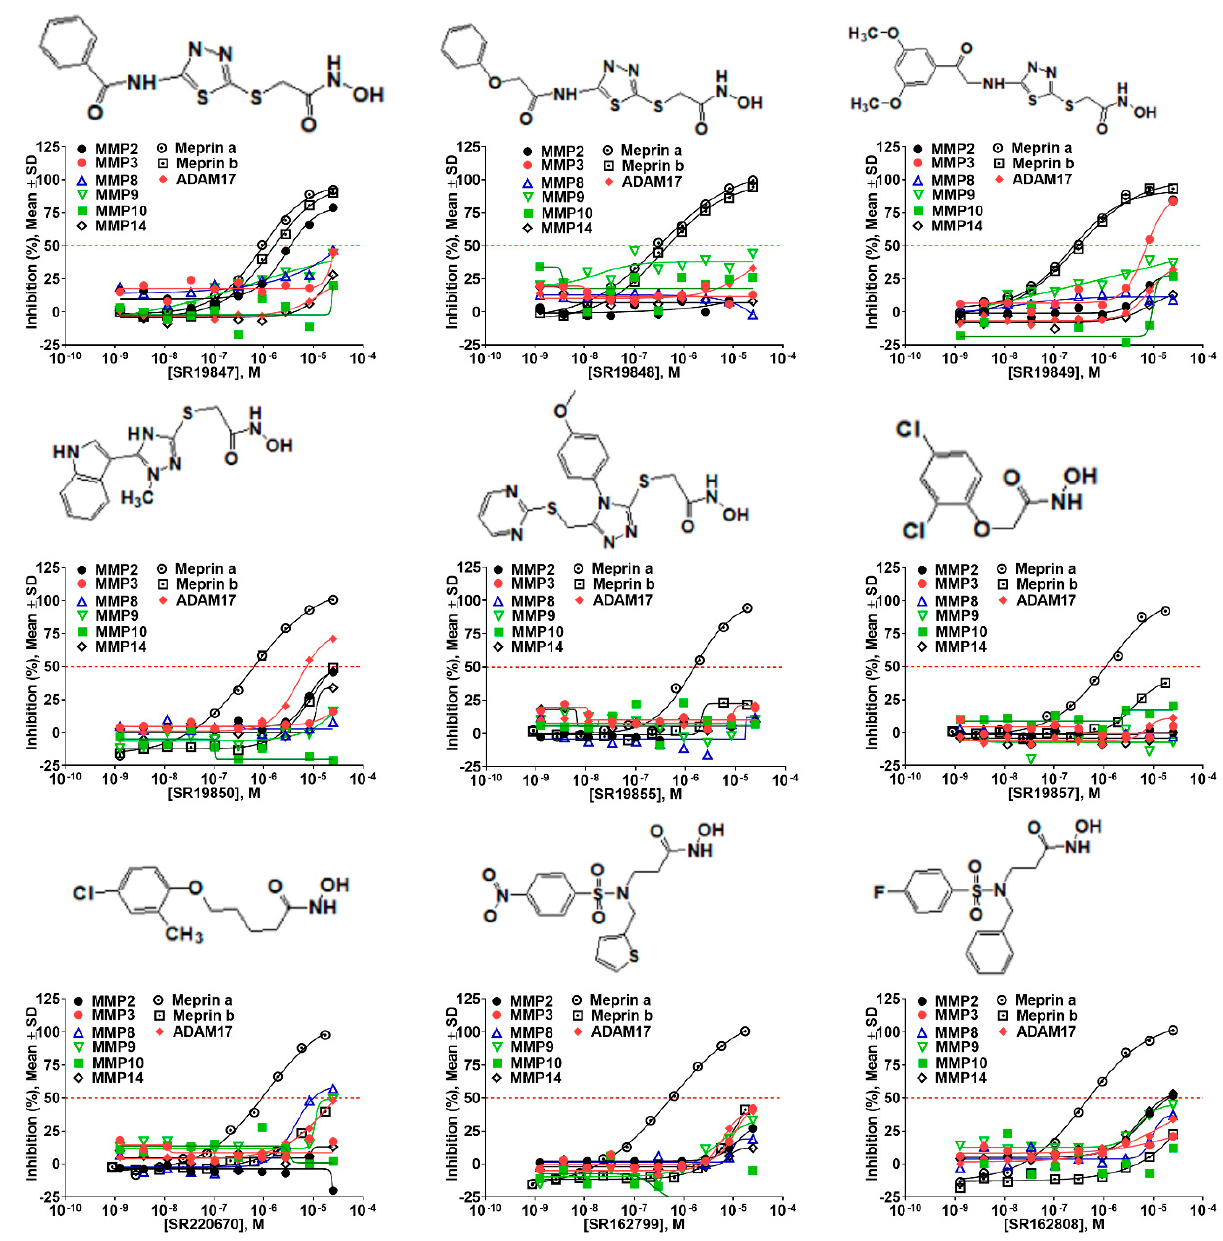
Figure 6. Results of concentration response studies of top potent and selective meprin α inhibitors. The top meprin β inhibitors belonged to two structural families (Figure 7 and Table 3), isobutyryl-tetrahydronaphthalen-amides (SR910128, SR910130, and SR910140) and nitrofuran-containing compounds (SR207820 and SR412882). Compound SR355996 was the only representative of the bis-nitrobenzoic acid scaffold. We also tested representative compounds from each scaffold for effects on skin fi- broblast and melanocyte viability to ascertain cytotoxicity towards various skin cell types. Overall, hits showed either no or very little effect on cell viability (Figure 8) suggesting a lack of general cytotoxicity and amenability of hit chemotypes for the development into in vitro probe for biological